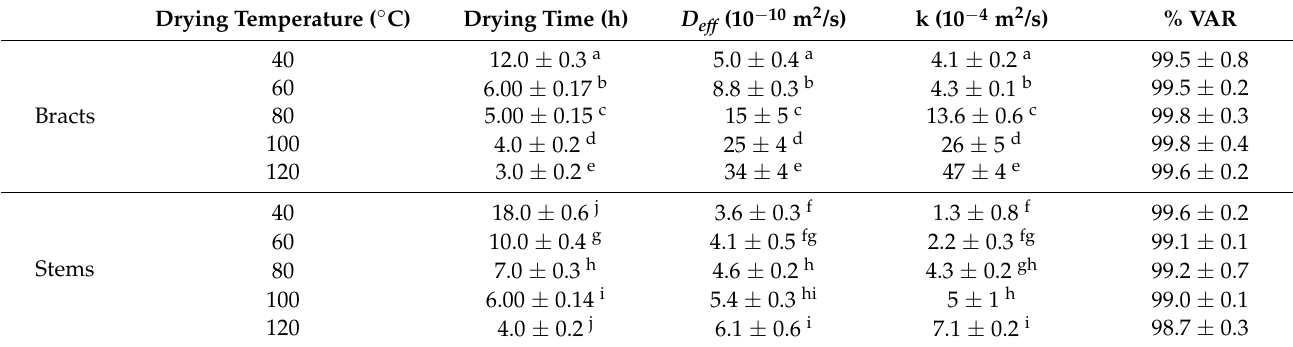
Table 1. Drying experiments of bracts and stems of artichoke at different temperatures. Drying time (h) needed to reach a moisture content of 0.25 kg W/kg dm. Effective diffusivity ( D eff ) and mass transfer coefficient (k) (average values and standard deviation) identified from modeling and percentage of variance (% VAR) explained by the